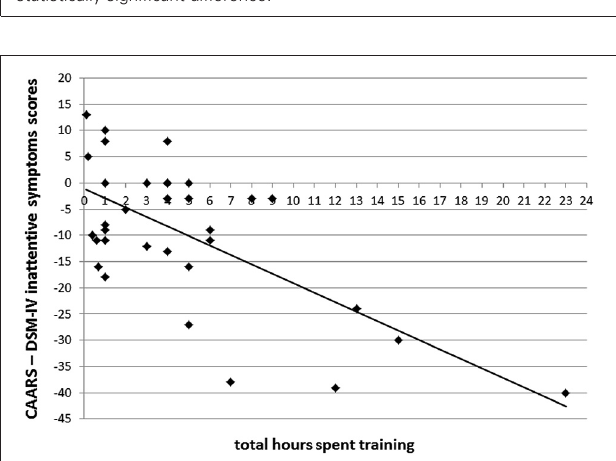
FIGURE 5 | Mean scores for the Self-Alert Training (SAT) and Control Training (CT) group at pre and post-training and at the 3-month follow up on the Attention related Cognitive Error Questionnaire (ARCEQ) . SAT participants significantly decreased their subjective ratings of attentional slips compared to CT participants after training and at the 3-month follow up. Error bars represent standard errors. ∗ Indicates statistically significant difference.